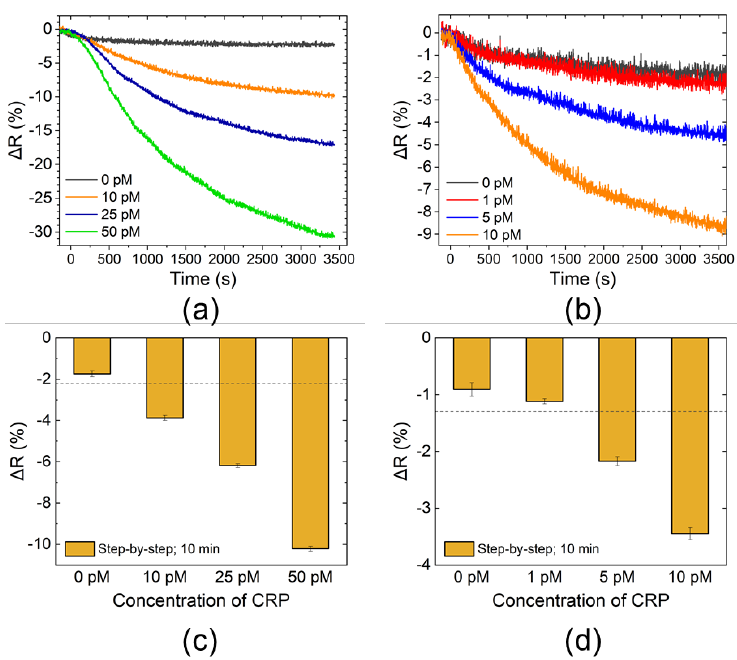
Figure 4. CRP detection results using step-by-step method. Time course of changes in reflectance (ΔR) measured using waveguide-mode sensor for ( a ) higher and ( b ) lower concentration samples. Values of ΔR at 10 min for ( c ) higher and ( d ) lower concentration samples. Bars show mean values of 10 data points around 10 min presented in ( a , b ), respectively. Error bars are standard deviations (σ). Dashed lines show values of mean minus 3.3 σ of 0 pM sample (blank solution).